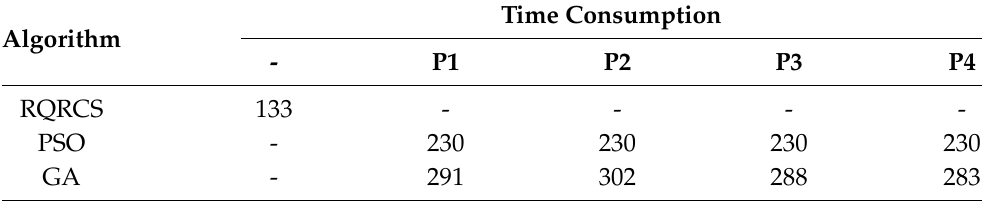
Figure 10. GA solution process based on different parameter settings. ( a ) GA process based on parameter P1, ( b ) GA process based on parameter P2, ( c ) GA process based on parameter P3, ( d ) GA process based on parameter P4. Table 7. Comparison of the time consumption of the three algorithm scheduling resource